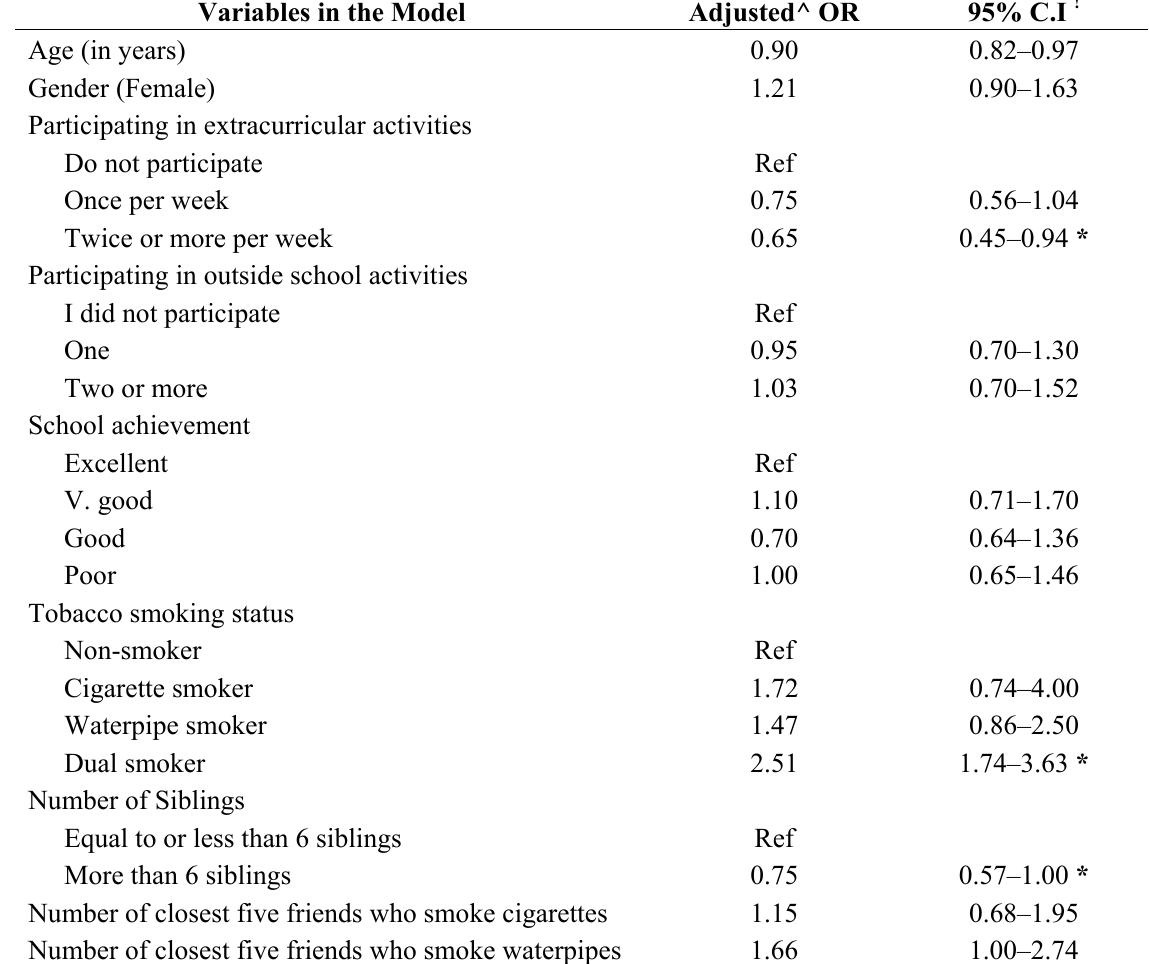
Table 5. Adjusted effect of tobacco smoking status on perceived health risk (logistic model) **